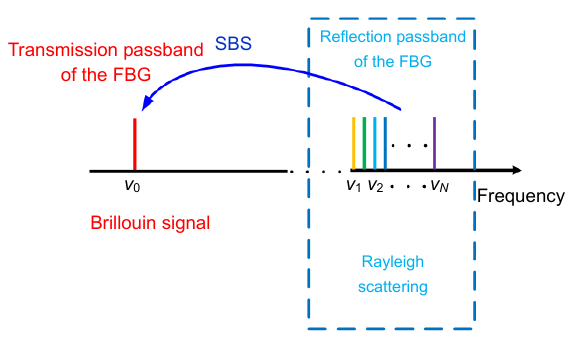
Fig. 2 | The frequency relationship between the Rayleigh scat- tering and Brillouin